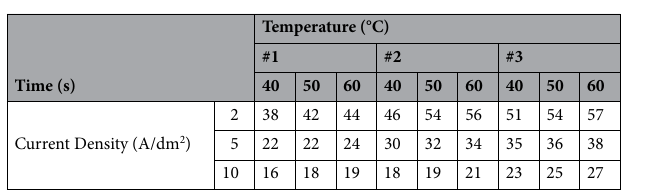
Table 6. Simulated flattened time of cathodes #1, #2, and #3 at various current densities and temperatures.